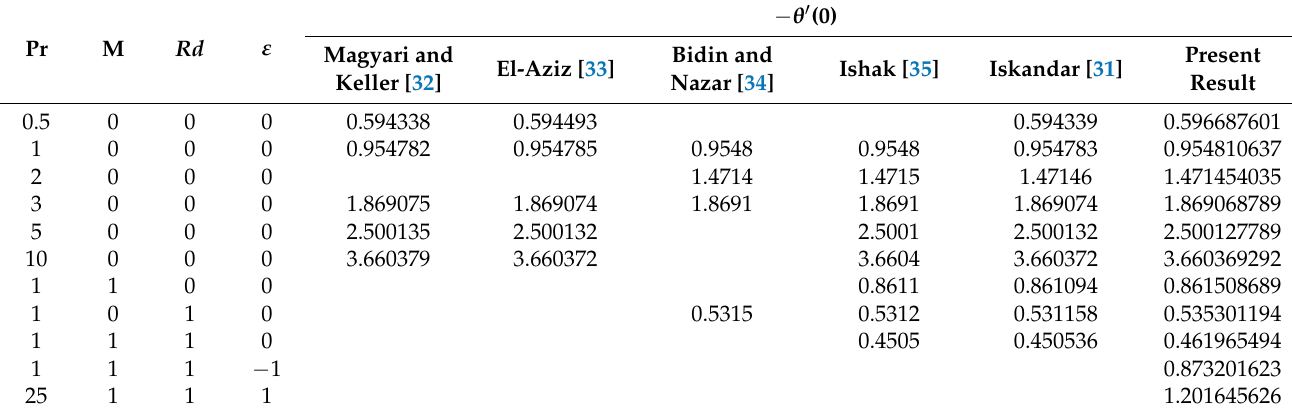
Table 4. Comparison several of numerical results of − θ (cid:48) (0) for various parameters ( λ = 1, ϕ 1 = ϕ 2 = 0, Gr =